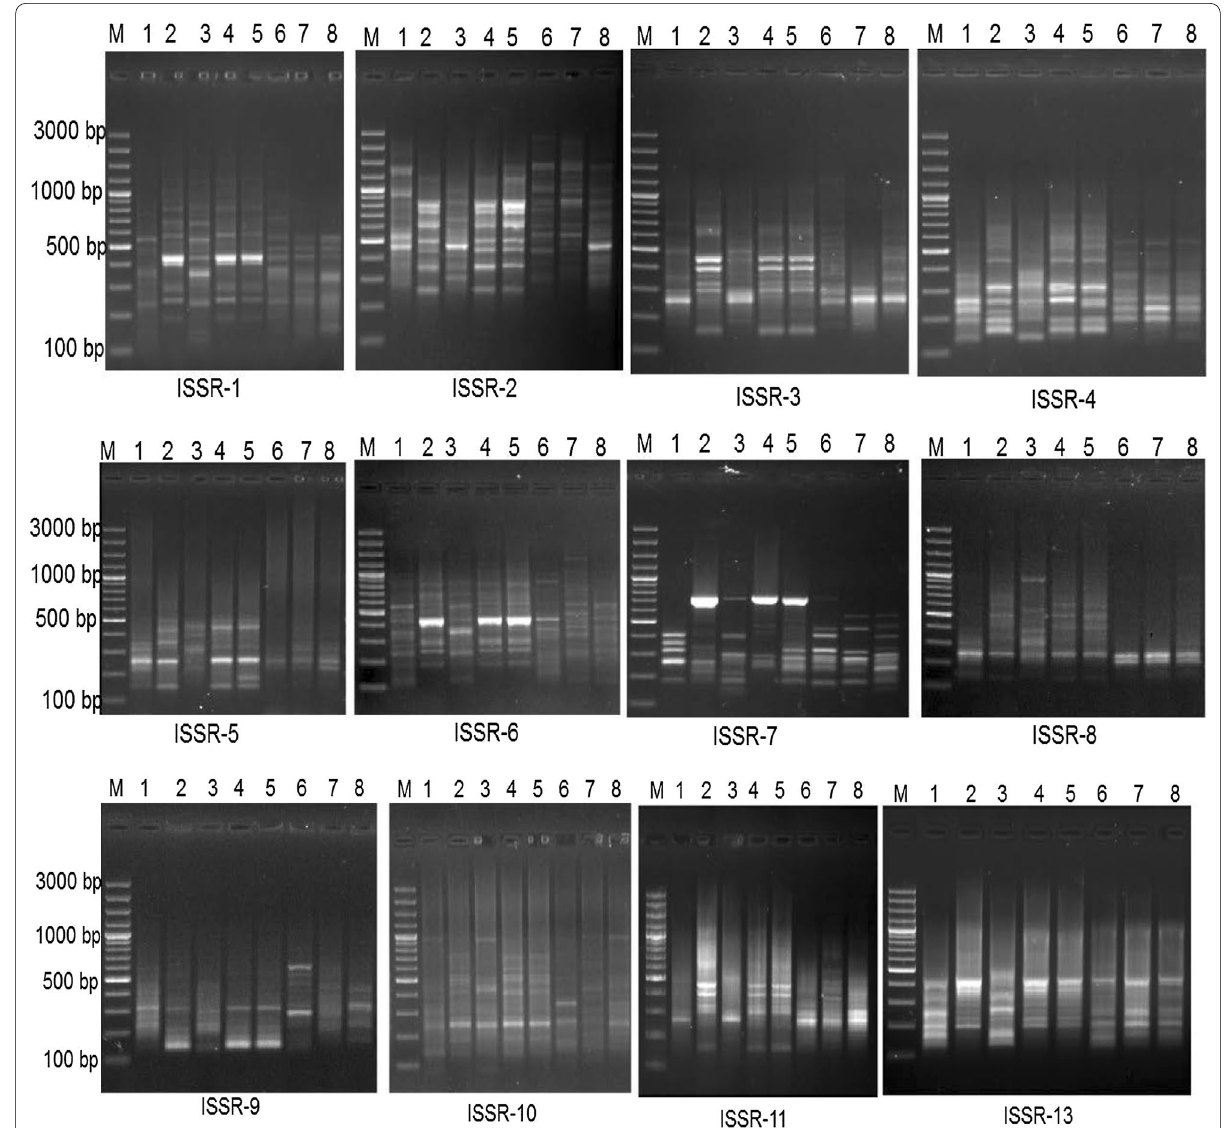
Fig. 3 The inter‑simple sequence repeat (ISSR) amplification pattern obtained in the eight Beta vulgaris genotypes, namely 1: Baraca, 2: B2001, 3: Sultan, 4: Mont Bianco, 5: Oscar Boly, 6: Blino, 7: Rass poly and 8: Pita poly terry using 12 ISSR primers,